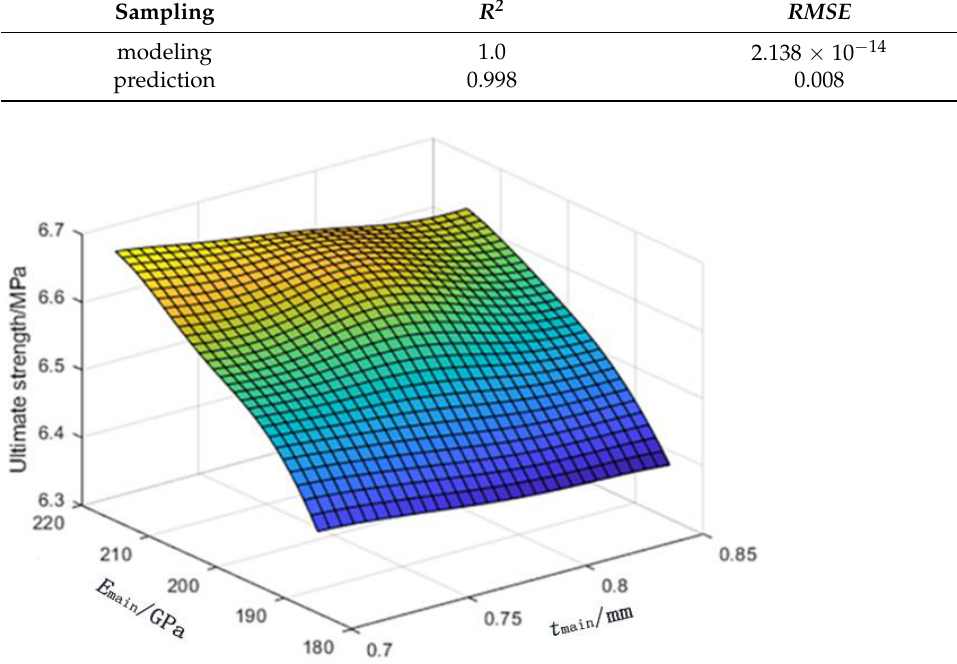
Table 6. Aleatory and epistemic uncertainty model inputs.